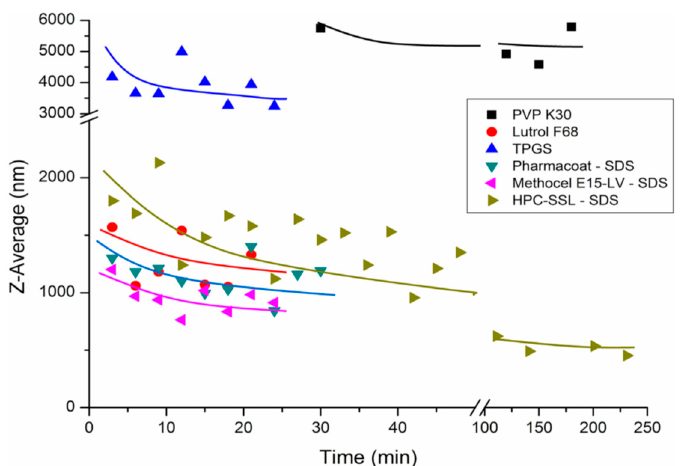
Figure 3. Effect of milling time on determined particle size for different stabilizers studied. Polydispersity index is below 0.5 in most of the batches. Reprinted from [75] with permission from Elsevier.